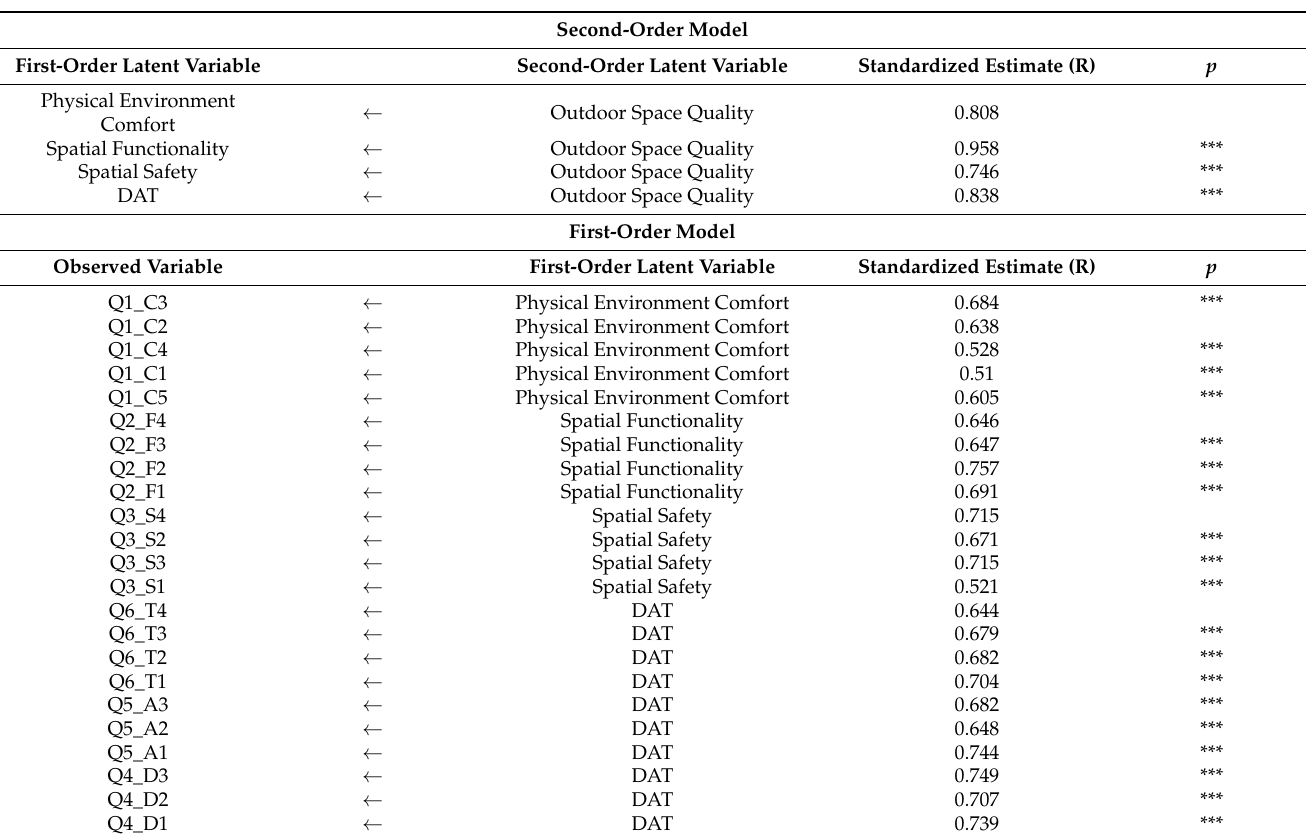
Table 8. Standardized Regression